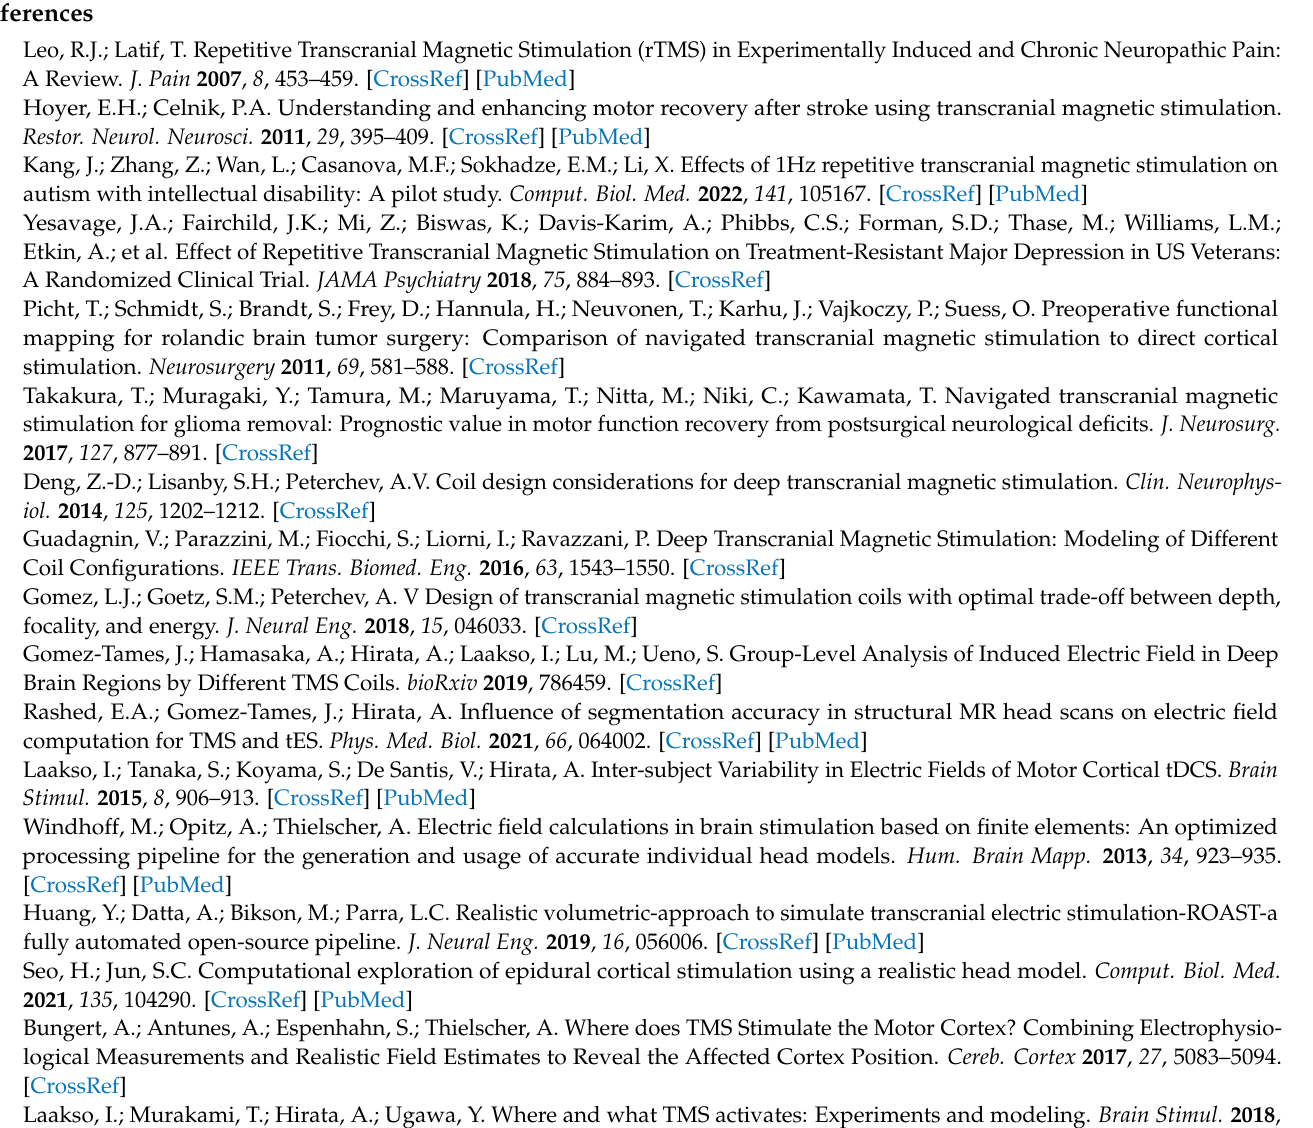
the highest five MEPs for each participant. Red and blue dots represent the FDI and ADM, respectively. Green dots indicate the samples that were common to the two muscles. Arrows indicate the coil orientation. There is not clear distinction between the two target muscles based only on the coil position projection in most participants. In our study, MRI data is used as a priori information to guide the coil position and orientation (sulcus-aligned TMS coil) above the probable motor